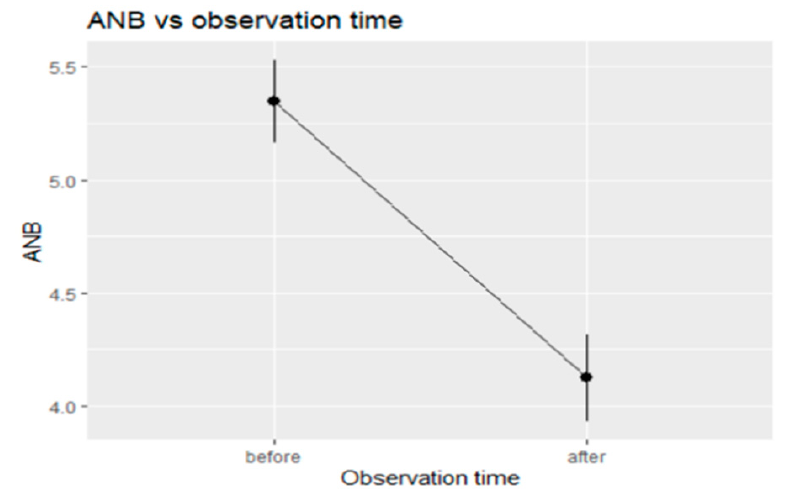
Figure 6. Trend in SNB over time from T0 to T1.